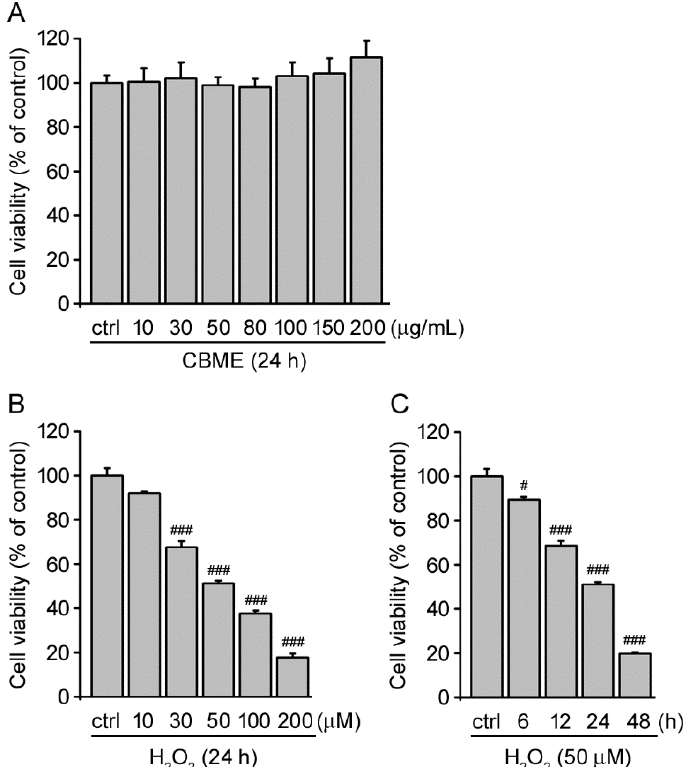
Figure 1. Effect of C. boreale Makino extract (CBME) and hydrogen peroxide (H 2 O 2 ) on cell viability in SH-SY5Y cells. ( A ) The cells were exposed to the indicated doses of CBME for 24 h. Cell viability was evaluated using a WST-1 assay. ( B ) The cells were exposed to the indicated concentrations of H 2 O 2 for 24 h. Cell viability was evaluated using the WST-1 assay. ( C ) The cells were incubated with 50 µ M H 2 O 2 for the indicated durations. Cell viability was evaluated using the WST-1 assay. The results are representative of four independent experiments. All data are presented as the mean ± SEM. # p < 0.05, ### p < 0.005, significantly different from the control